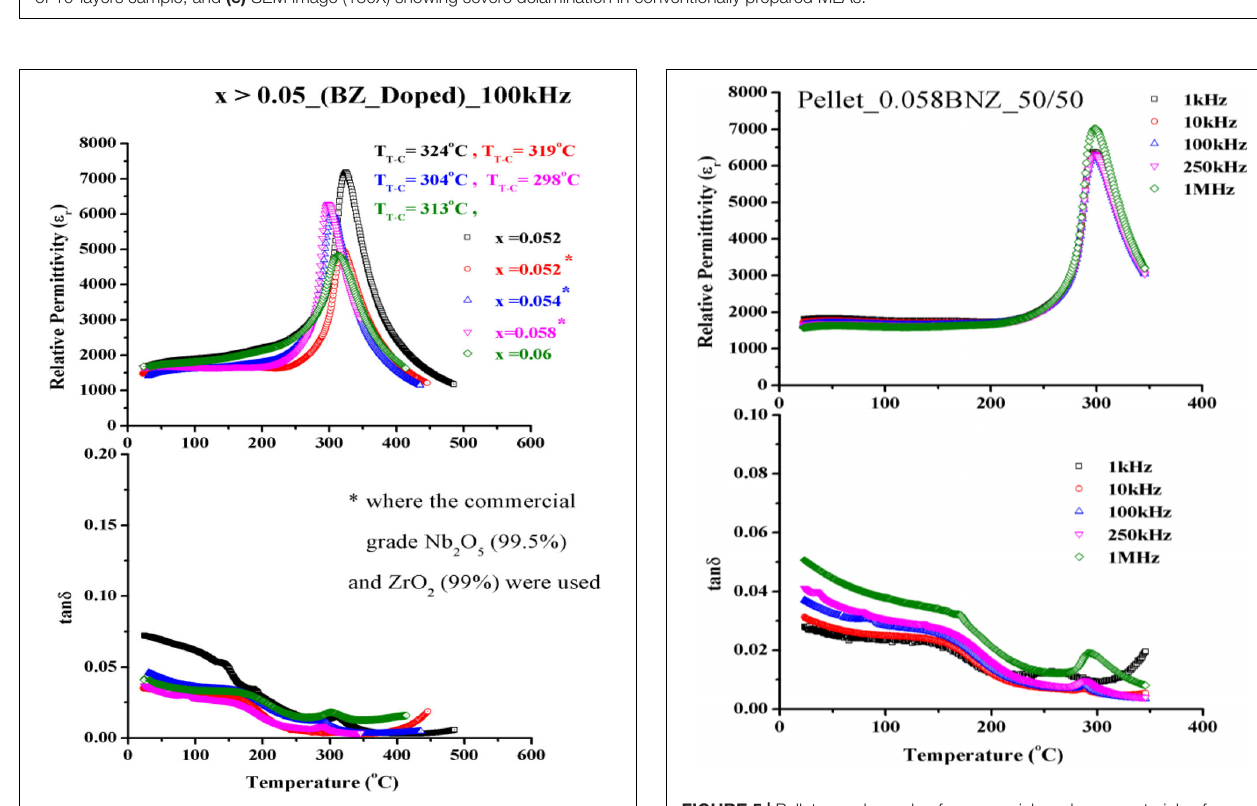
FIGURE 4 | Relative permittivity vs. tan δ loss of BNZ doped where (0.05 ≤ x ≤ 0.06), compared with commercial grade raw materials.